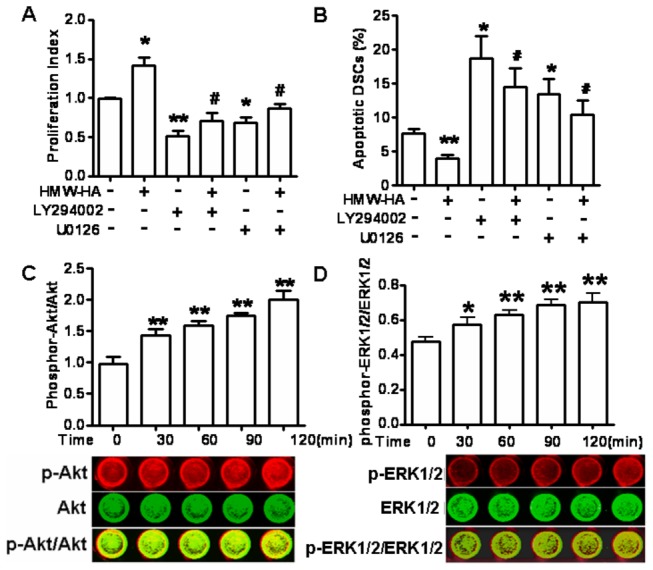
PI3K/AKT and MAPK/ERK1/2 pathways are involved in the HA/CD44-regulated DSC proliferation and apoptosis.The DSCs were treated for 48 h with either 0.1% DMSO (control/vehicle), 100 µg/ml HMW-HA, 50 µM PI3K/AKT inhibitor LY294002, 30 µM MEK1/2 inhibitor U0126, or 100 µg/ml HWW-HA combined with 50µM LY294002 or 30µM U0126. BrdU proliferation assay (A) and flow cytometry (B) were used to detect the proliferation and apoptosis, respectively. In-cell Western (C, D) HMW-HA activated in vitro PI3K/AKT and MAPK/ERK1/2 of DSC cells. The primary-cultured DSCs were starved with FBS-free media for 12 h and then treated with 100 µg/ml HMW-HA for different time. The levels of phosphor- and total- AKT and ERK1/2 were determined by In-cell Western. The pictures were from the typical one of three individual experiments. The red represents phospho-AKT or ERK1/2 and the green represents total- AKT or ERK1/2. Data represent the mean±SE of three experiments performed in triplicate wells. *P≤0.05, **P≤0.01 compared to the control; #
P<0.05, compared to HMW-HA treatment.